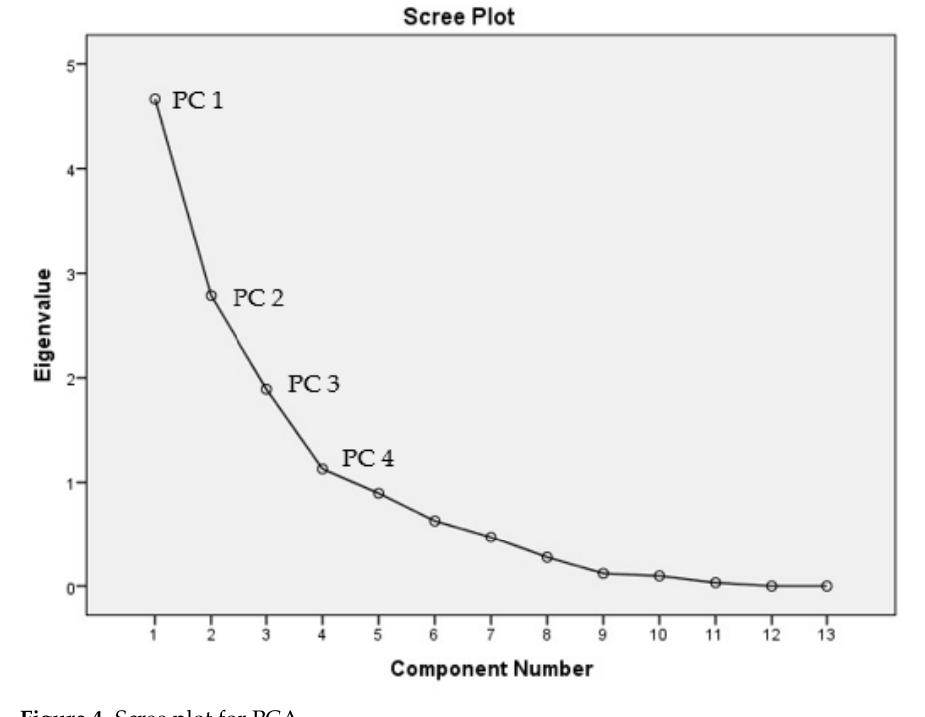
Figure 4. Scree plot for PCA.